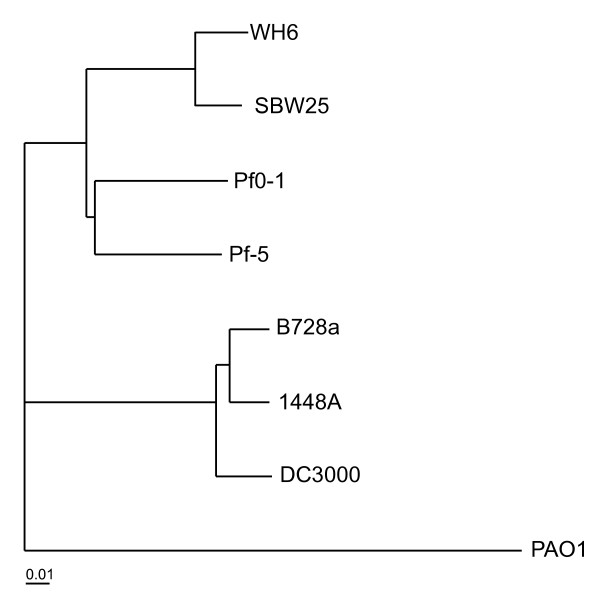
Phylogenomic tree of eight Pseudomonas isolates based on a super alignment of 1966 translated sequences. P. fluorescens isolates: WH6, SBW25, Pf-5, and Pf0-1; P. syringae pathovars: tomato DC3000, phaseolicola 1448A, and syringae B728a; P. aeruginosa PAO1. Bootstrap support for nodes (r = 1000) were all 100. The scale bar indicates the number of amino acid substitutions per site.